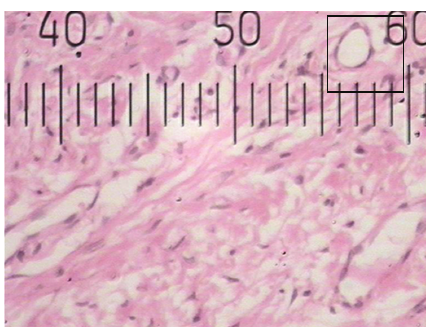
Figure 6: Histopathological photograph of gingival tissue in nonsmoker showing inflammatory